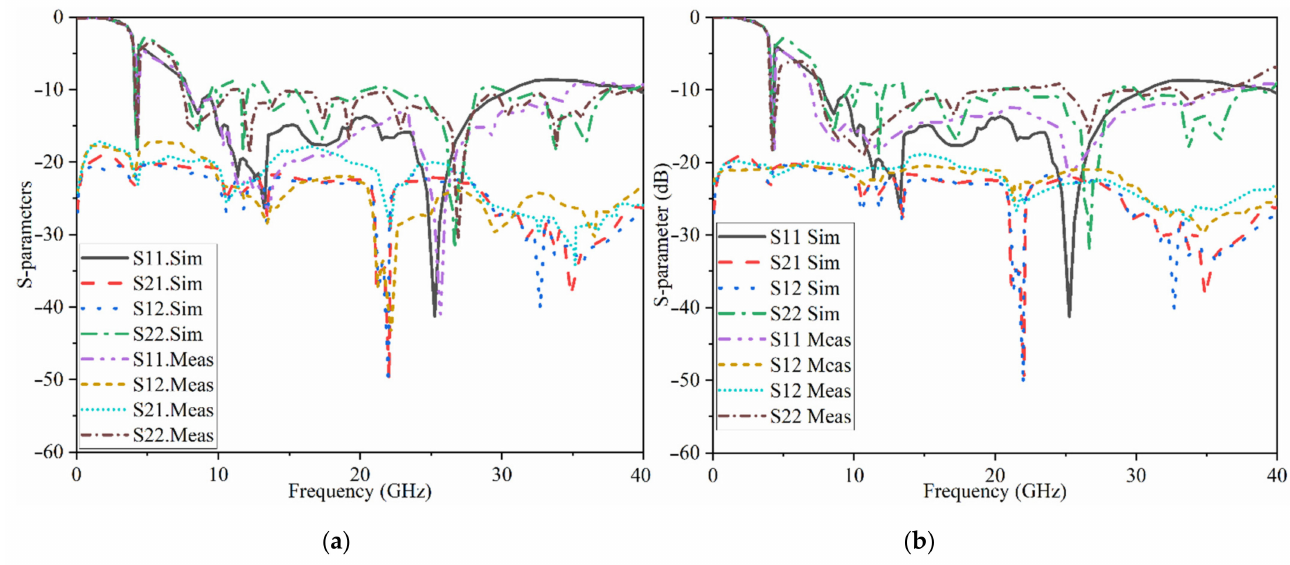
Figure 31. The simulated and measured reflection and transmission coefficient results on ( a ) arm and ( b ) chest for single element